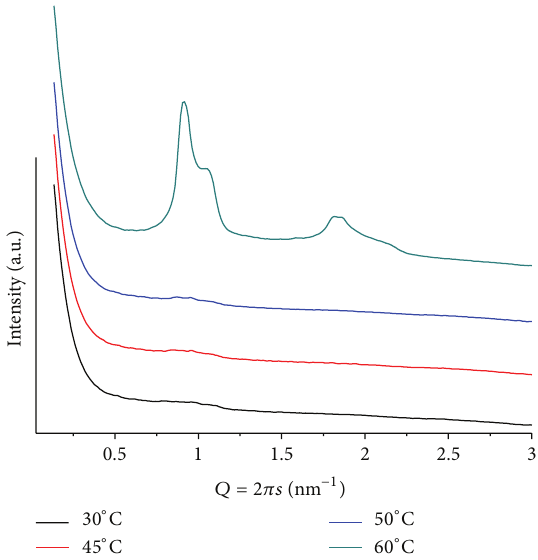
Figure 2: SAXS patterns at different temperatures for POPC/ANQ, mr = 100 and pH = 4 .